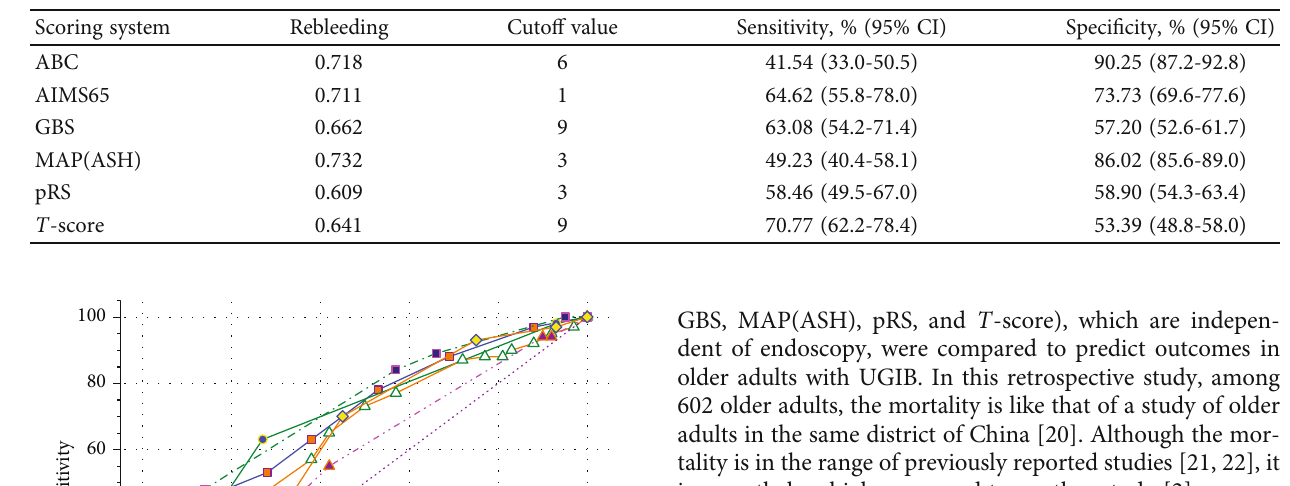
Table 6: Values of the six scoring systems in prediction of rebleeding.